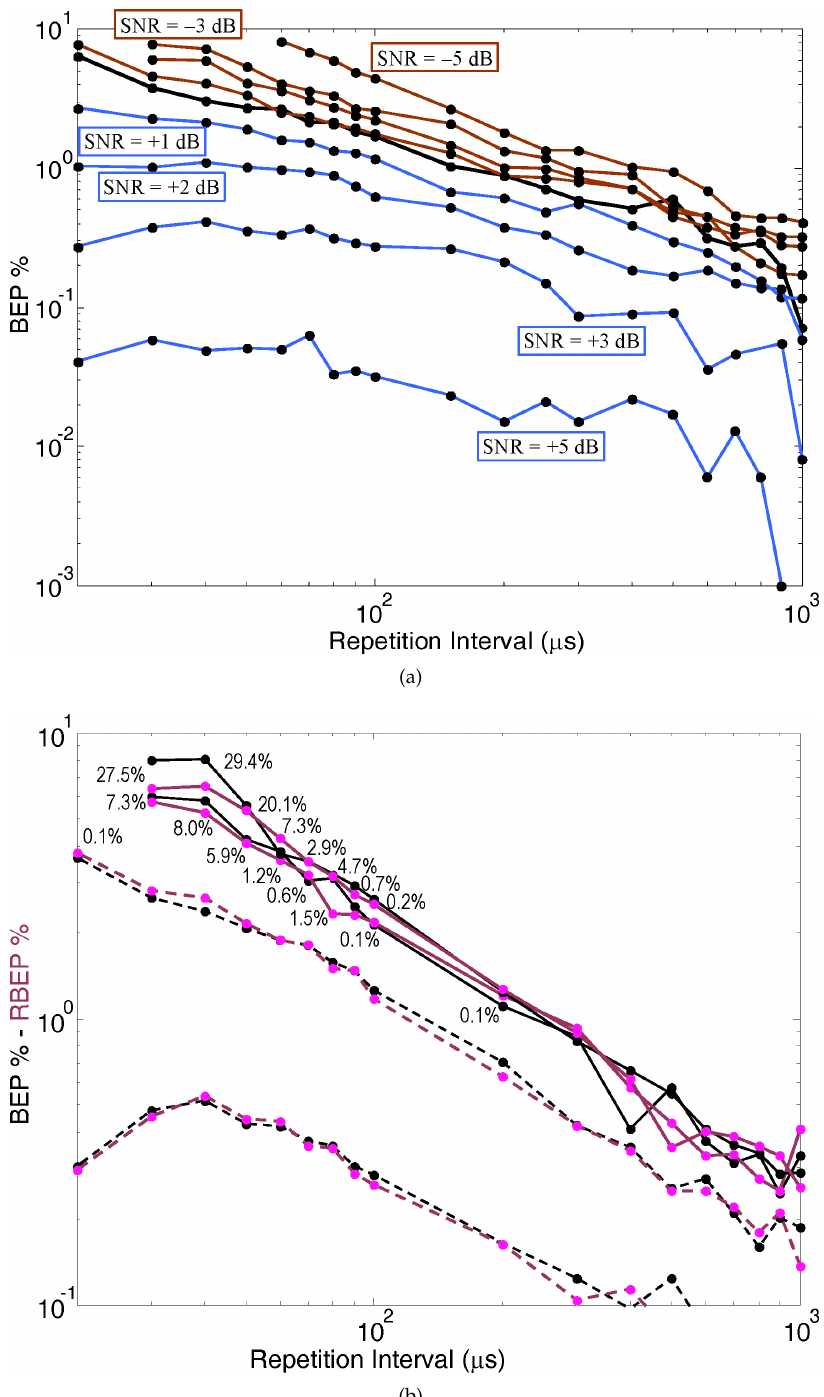
Figure 8. Dependency of the repetition frequency [145] on ( a ) BEP as a function of RI for different SNR values (the black thick curve corresponds to 0dB); values missing for the lowest SNR and RI values refer to failed tests with loss of the communication link due to excessive errors. ( b ) BEP (black curves) and RBEP (plum curves) as a function of RI for different SNR values; dashed curves indicate SNR values of 0 dB and +3 dB with a 0 frame error rate (FER); solid curves are for SNR values of − 2dB and − 3dB and the non-null FER values are indicated by a number next to each dot. © 2012 IEEE. Reprinted, with permission, from